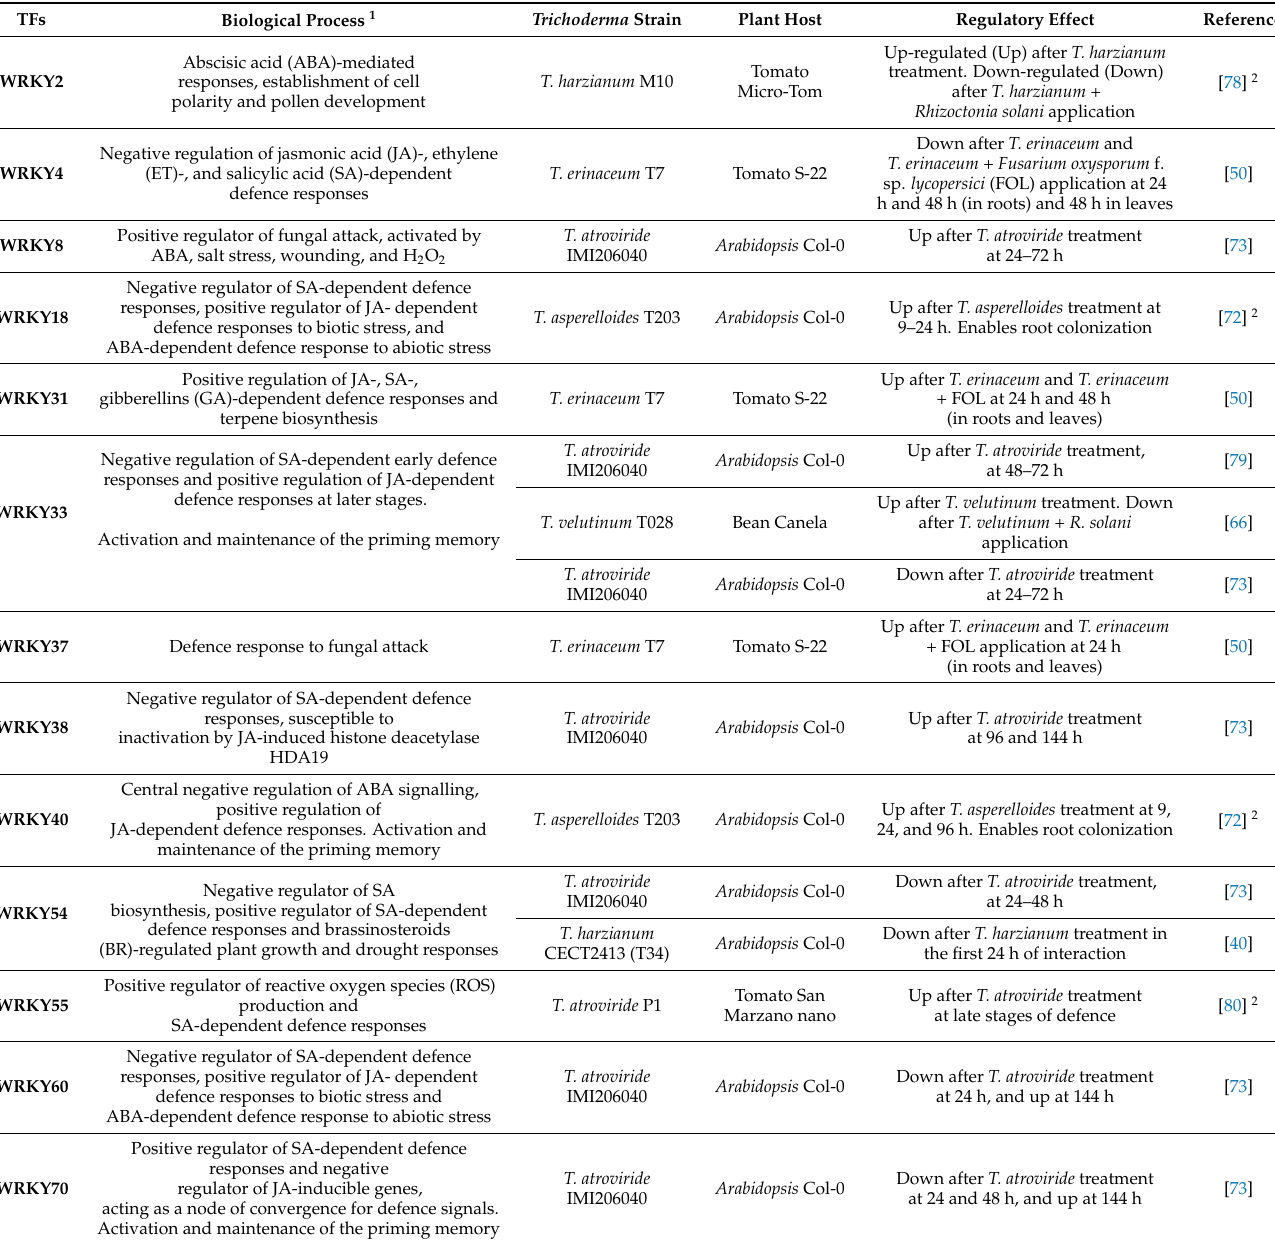
Table 1. Summary of plant WRKY, MYB, and MYC transcription factors (TF) regulated by Trichoderma spp. interactions through mitogen-activated protein kinases (MAPK) or Ca 2+ -dependent protein kinase (CDPK) cascades and their biological effects on plant